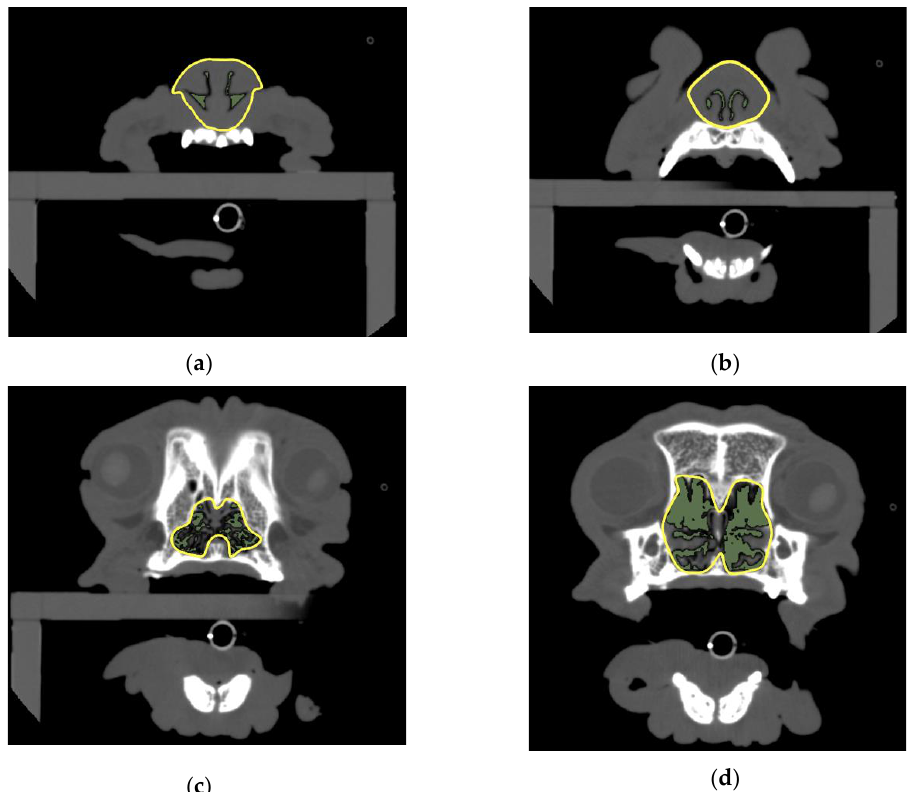
Figure 1. Measurements of the AA/NC ratio.( a ) Cross section showing alveolar bone of first incisor tooth; ( b ) canine tooth level: cross section showing alveolar bone of canine tooth; ( c ) palatal horizontal plate level: the most rostral cross section showing the palatine horizontal plate; ( d ) suborbital foramen level: the most caudal cross section showing both suborbital foramina. AA/NC, airway cross-sectional area/total nasal cavity area.